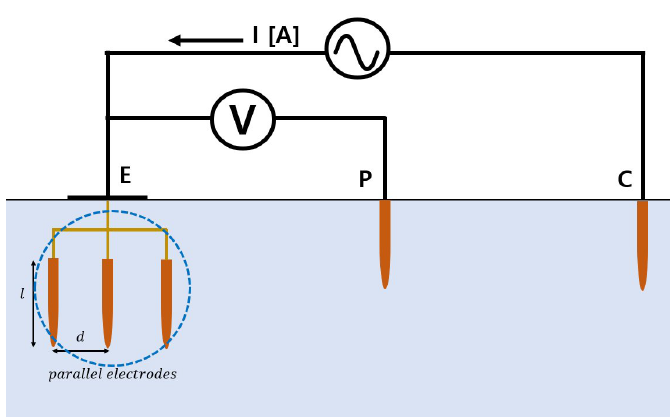
Figure 7. Measurement of parallel grounding resistance by the fall-of potential method (No. of electrode: